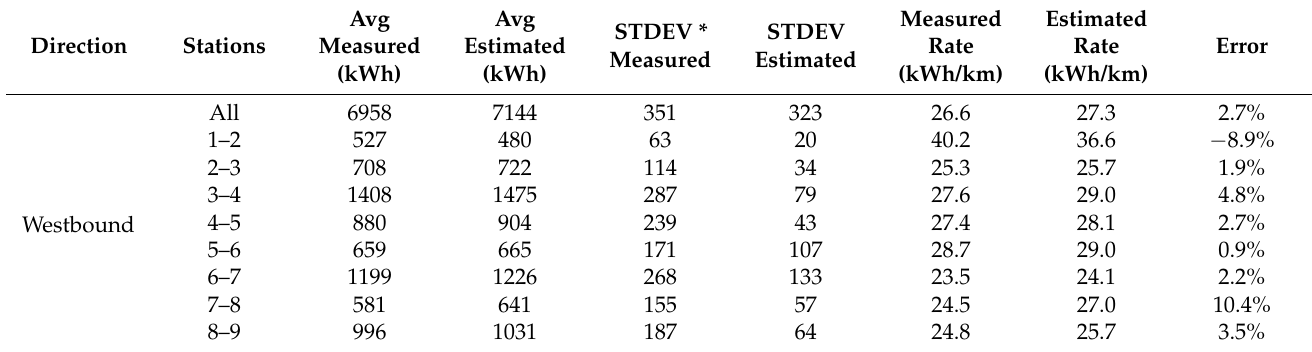
( b ) ( c ) Figure 7. Model validation using Valencia to Cuenca trip data: ( a ) speed profile of a sample section, ( b ) altitude, ( c ) energy consumption.